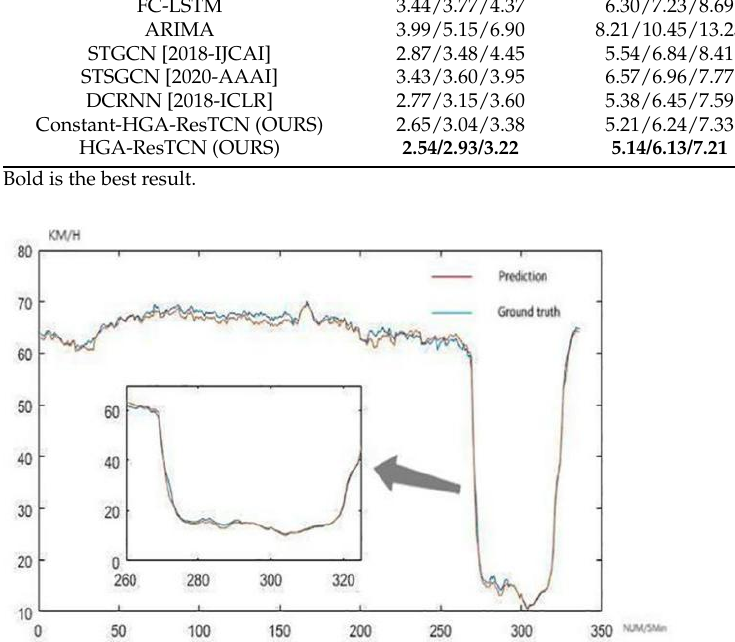
Figure 3. Traffic prediction and the corresponding ground truth of a sensor during 336 time